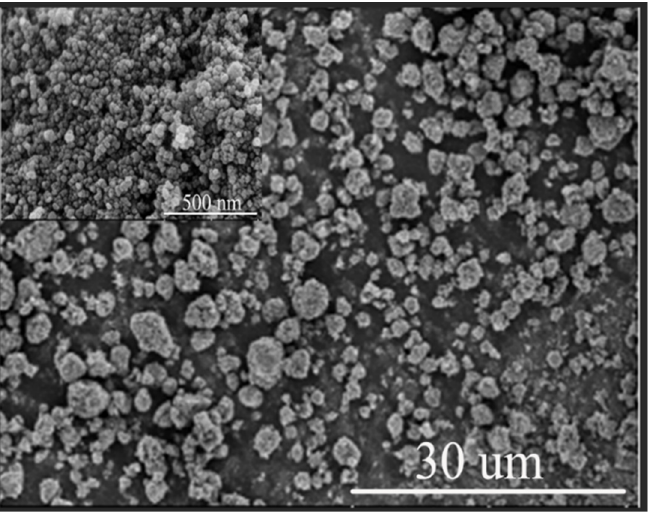
Figure 1. SEM images of carbon black.